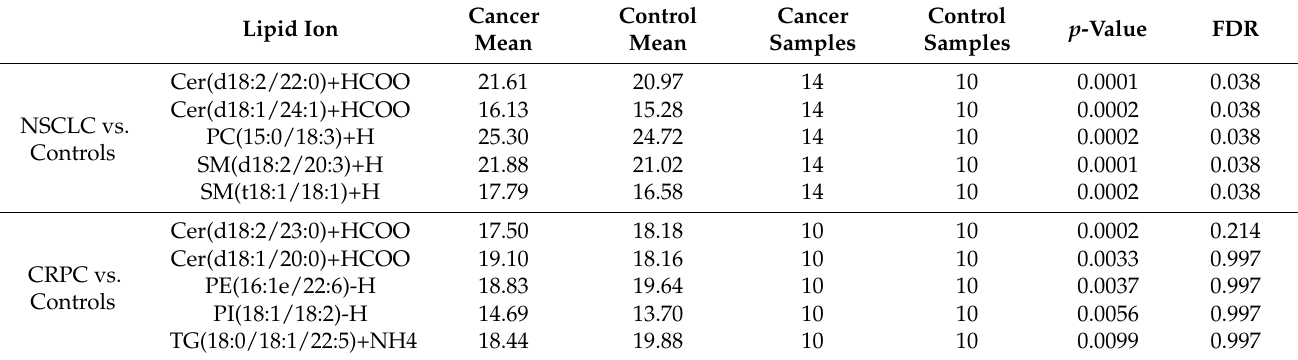
Table 2. Top 5 differentially abundant lipids from SEC enriched exosomes in NSCLC and